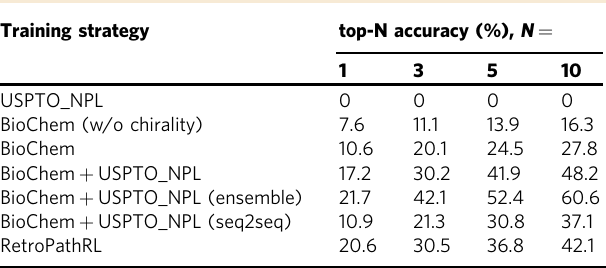
Table 1 Performance of single-step models by different training